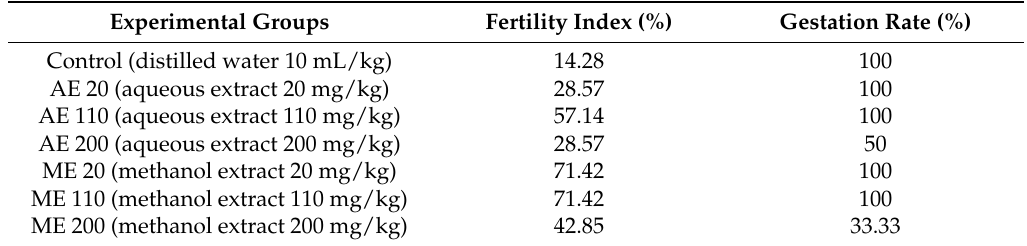
Table 2. Effects of the aqueous and the methanol extracts of M. arboreus on fertility and gestation index.